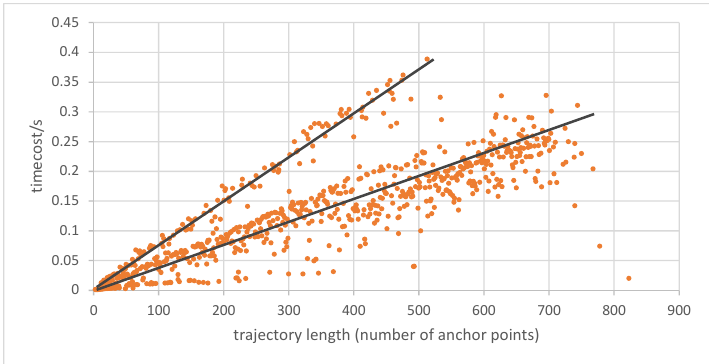
Figure 11. Uncertain Trajectory Similarity Measure (UTSM) computation time-cost of trajectories with different